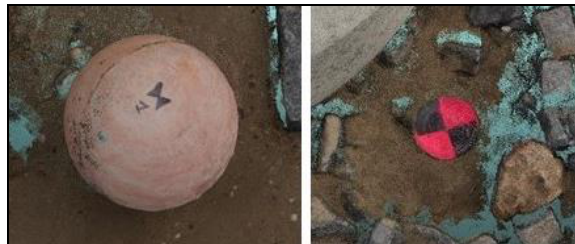
Figure 5. Spherical (on the left) and flat (on the right) targets